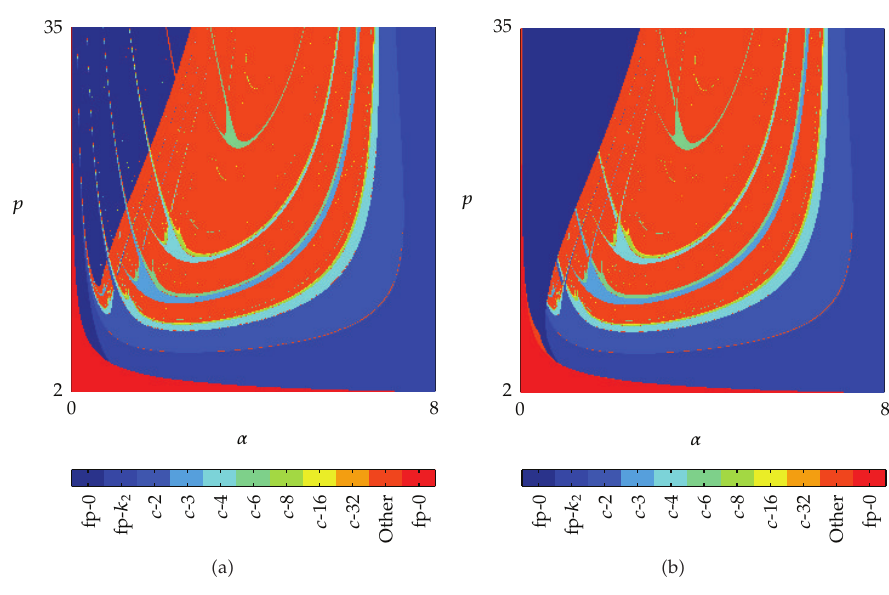
Figure 10: Two dimensional bifurcation diagrams of map F in the plain (cid:3) α,p (cid:6) for the following parameter values: δ (cid:7) 0 . 2, s r (cid:7) 0 . 7, s w (cid:7) 0 . 1, β (cid:7) 0 . 9, n (cid:7) 0 . 5; (cid:3) a (cid:6) the initial condition is k M ; (cid:3) b (cid:6) the initial condition is k m